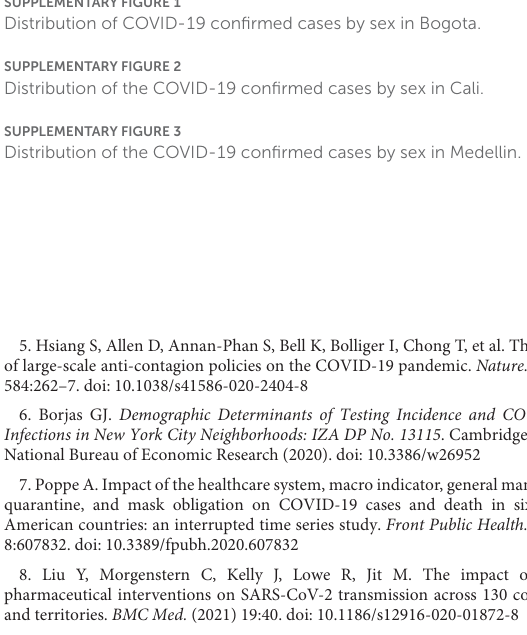
SUPPLEMENTARYFIGURE1 Distribution of COVID-19 confirmed cases by sex in Bogota. SUPPLEMENTARYFIGURE2 Distribution of the COVID-19 confirmed cases by sex in Cali. SUPPLEMENTARYFIGURE3 Distribution of the COVID-19 confirmed cases by sex in